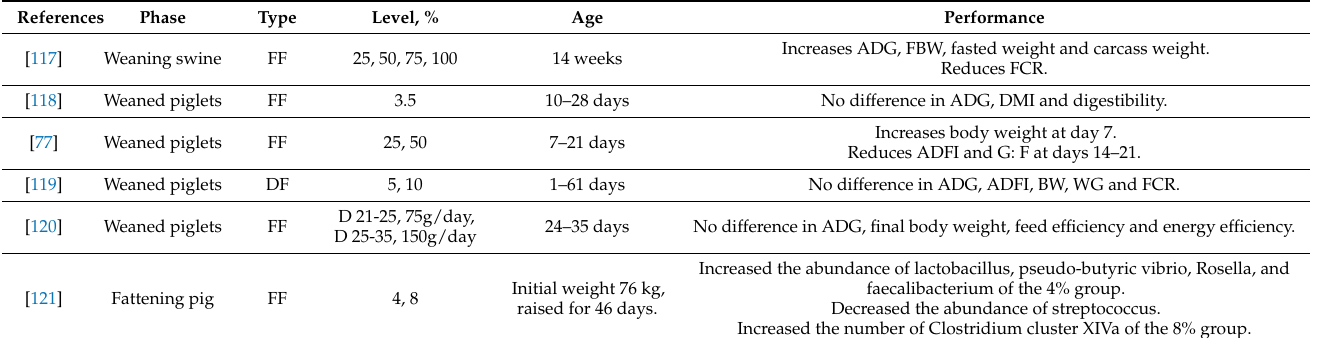
Table 8. Effects of BSFL on the growth performance of swine.